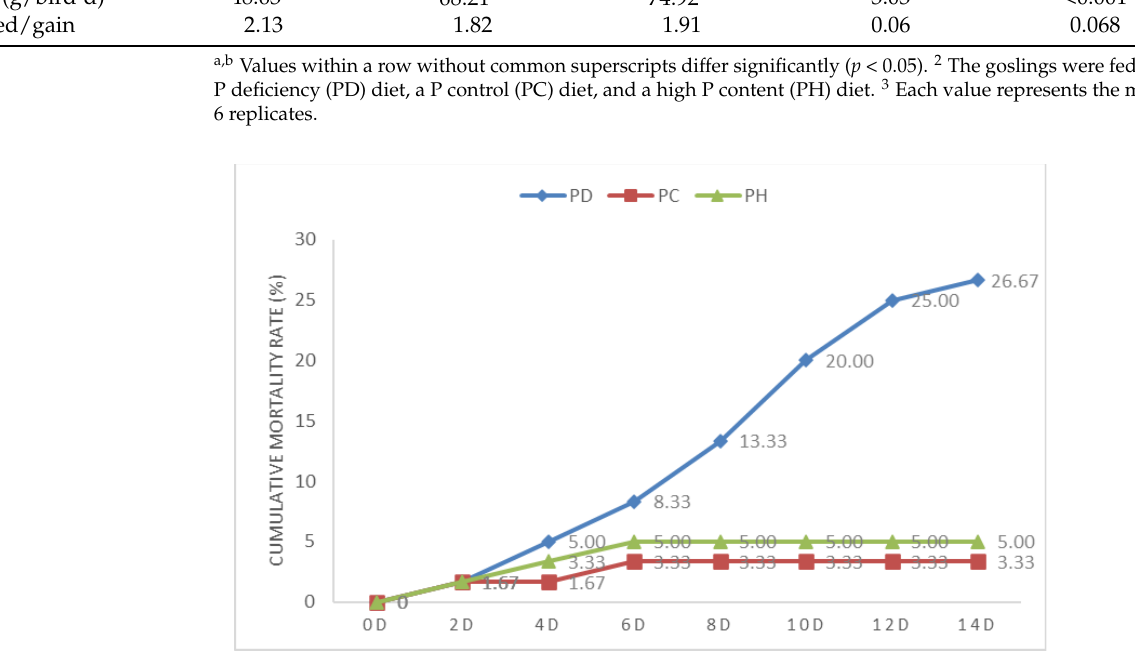
Figure 1. Cumulative mortality of goslings. The goslings were fed, respectively, with P deficiency (PD) diet, P control (PC) diet, and a high P content (PH) diet. Table 3. Effects of dietary phosphorus (P) deficiency and high P content on growth performance of 14-day-old goslings.